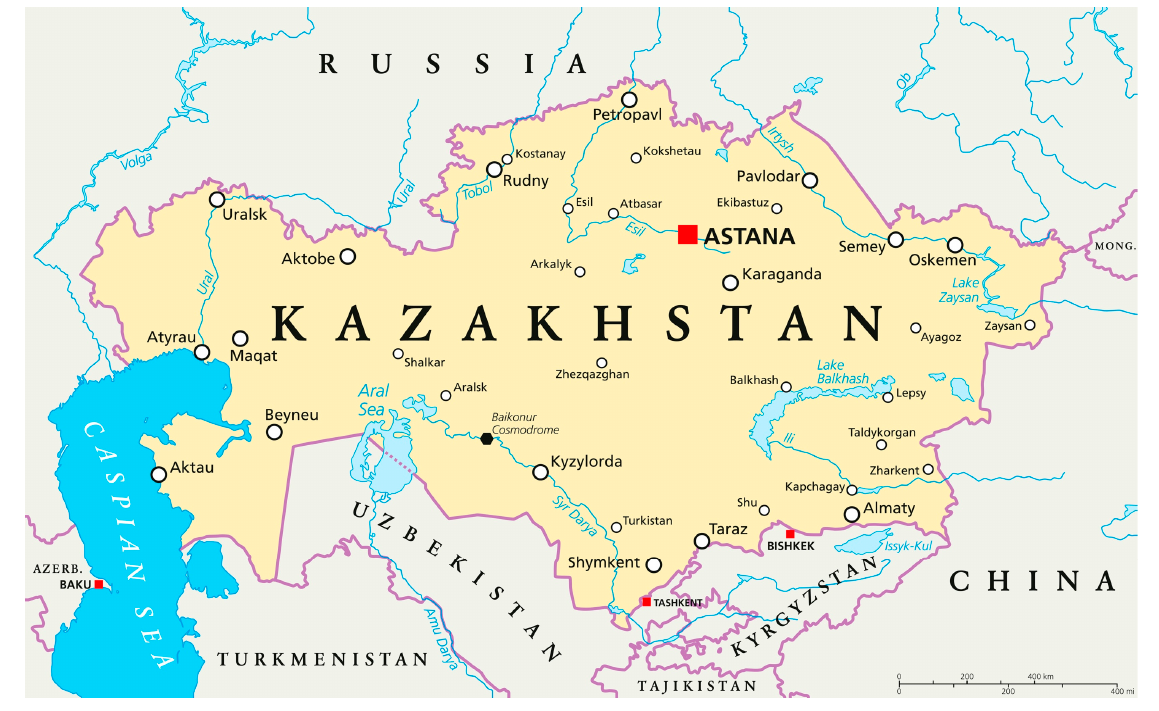
Figure 1. Map of Kazakhstan. Talgar is 25 km east of Almaty. As the river opens onto the alluvial deposits, there is a fan of stream channels branch- ing north toward the desert steppe. This alluvial fan, along with at least 14 fans along the base of the Zailiisky Alatau range, forms a band of rich arable steppe land on the south side of the Ili River Basin. Tuzusai, a large Iron Age settlement dating from 590 BC to 75 CE (the entire range of calibrated radiometric dates), is about 8 to 10 hectares in size. Taldy Bulak 2 is smaller in size (less than 2 hectares) and has radiometric dates indicating activ- ity from 775 BC to 40 BC (see Figure 2, Google Maps image of the Talgar fan). Both settle-